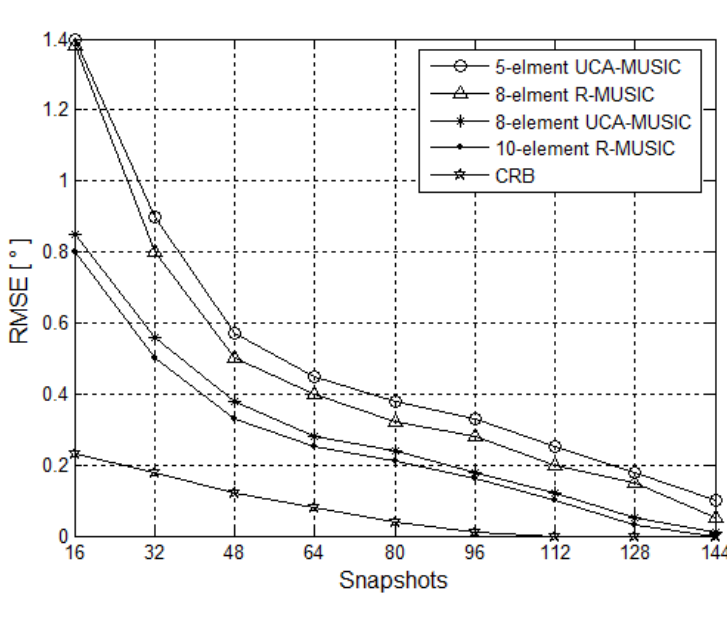
Figure 7. RMSE versus